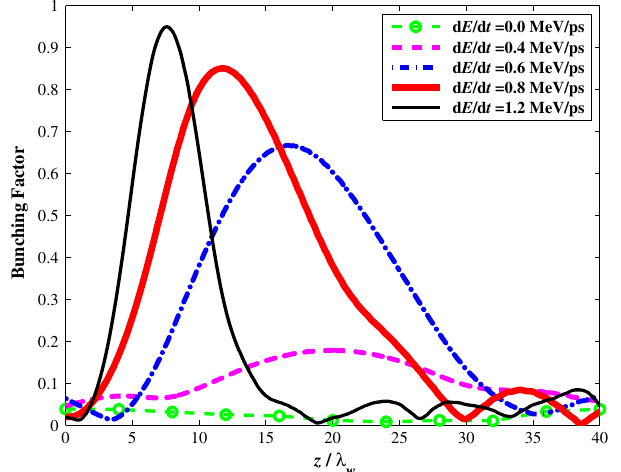
FIG. 1. Evolution of the bunching factor along the bunch trajectory in the ECSE FEL. The bunch charge Q b ¼ 30 pC, and the bunch duration f s T b ≈ 1 . Random Gauss initial distribution of N q ¼ 300 charged particles.